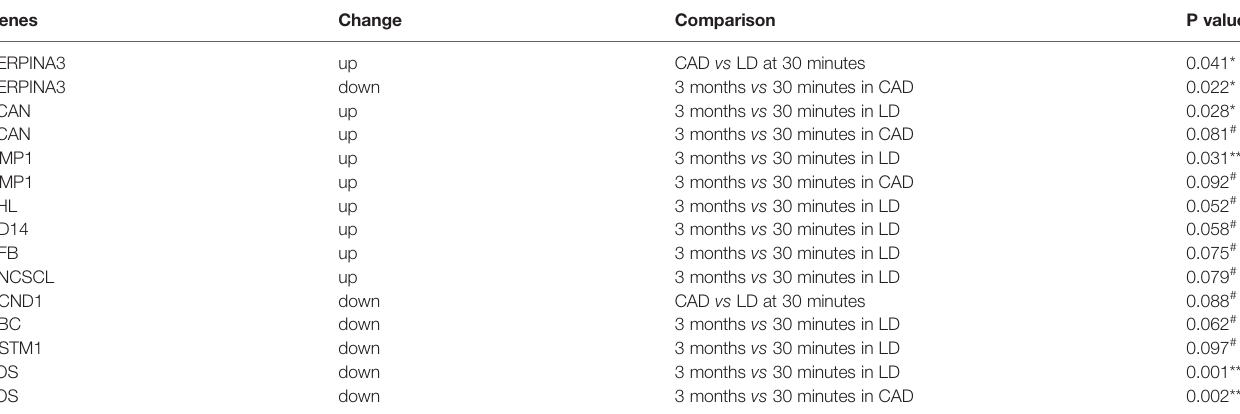
TABLE 3 | Signi fi cantly dysregulated genes in 33 additional biopsies validated by qPCR among 20 DEGs relevant to renal diseases. Genes